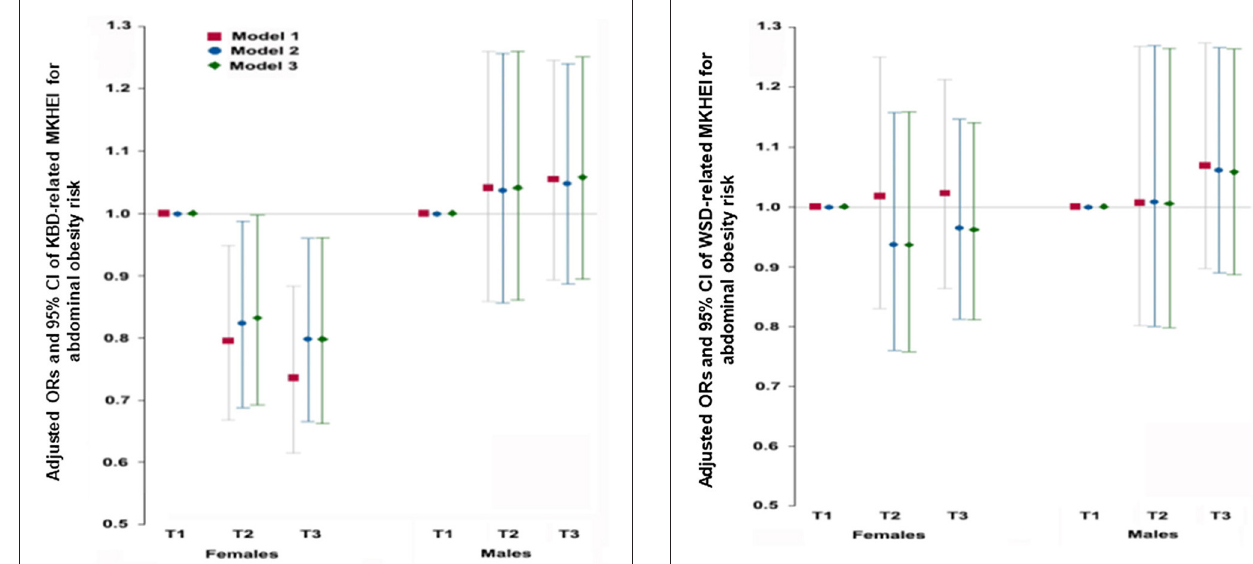
FIGURE 2 | Adjusted odds ratios (95% CI) for obesity calculated by waist circumference after adjustments for covariates according to Korean balanced diet scores. Korean balanced diet scores were calculated by summing the mixed grains intake scores, vegetable intake excluding kimchi and pickled vegetable intake, fermented vegetables kimchi and pickled vegetables, fish, beans including fermented beans, seaweed intake, and percentage of energy from polyunsaturated fatty acids. Model 1; adjusted for age and residence region. Model 2; adjusted for the covariates of model 1 + education, income, and marital status. Model 3: adjusted for the covariates of model 2 + smoking, alcohol, regular exercise.